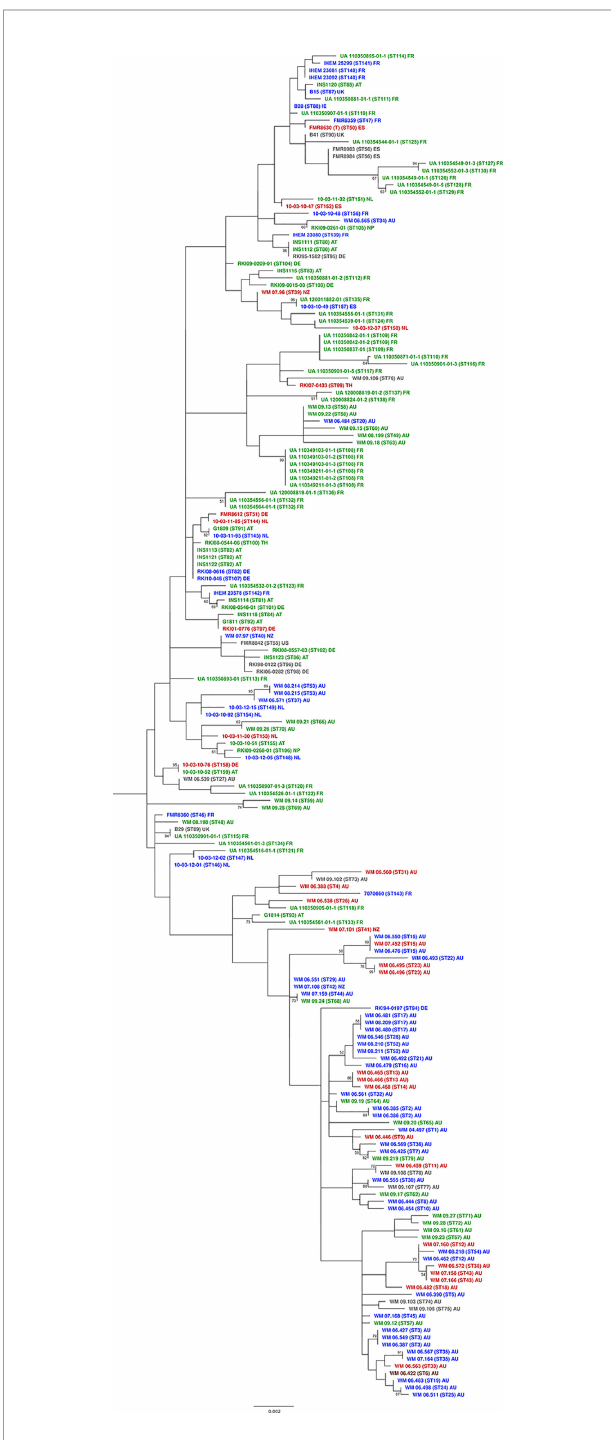
FIGURE 2 | MLST maximum parsimony tree. Combined maximum parsimony tree for the six MLST loci ( ACT , CAL, EF1 a , RPB2 , SOD2 and TUB ) generated from all obtained Scedosporium aurantiacum sequences using the program MEGA version 11. Environmental isolates (green), clinical invasive isolates (red), clinical colonizing isolates (blue), clinical isolates without information (grey), and veterinary isolates (brown). AT, Austria; AU, Australia; DE, Germany; ES, Spain; FR, France; UK, United Kingdom; IE, Ireland; NL, The Netherlands; NP, Nepal; NZ, New Zealand; TH, Thailand; and US,